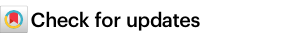
Supplementary Fig. 22: ‘ reprinted (adapted) from ref. 68 Copyright 2021 American Chemical Society.